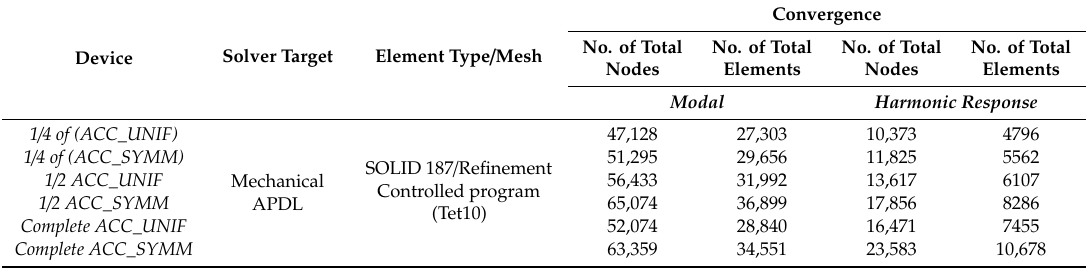
Table 11. Technical details about the FEA simulations for frequencies of modal and harmonic